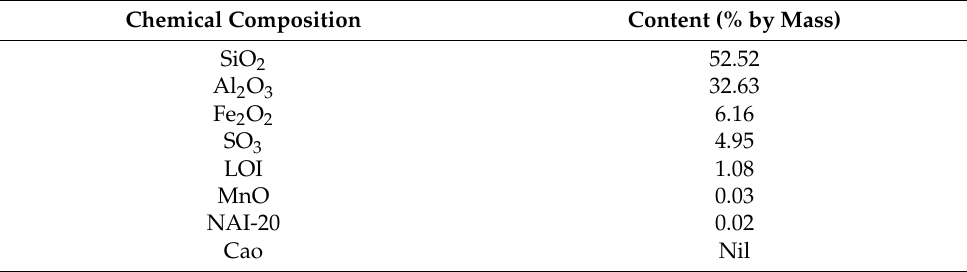
Table 2. Chemical properties of fly